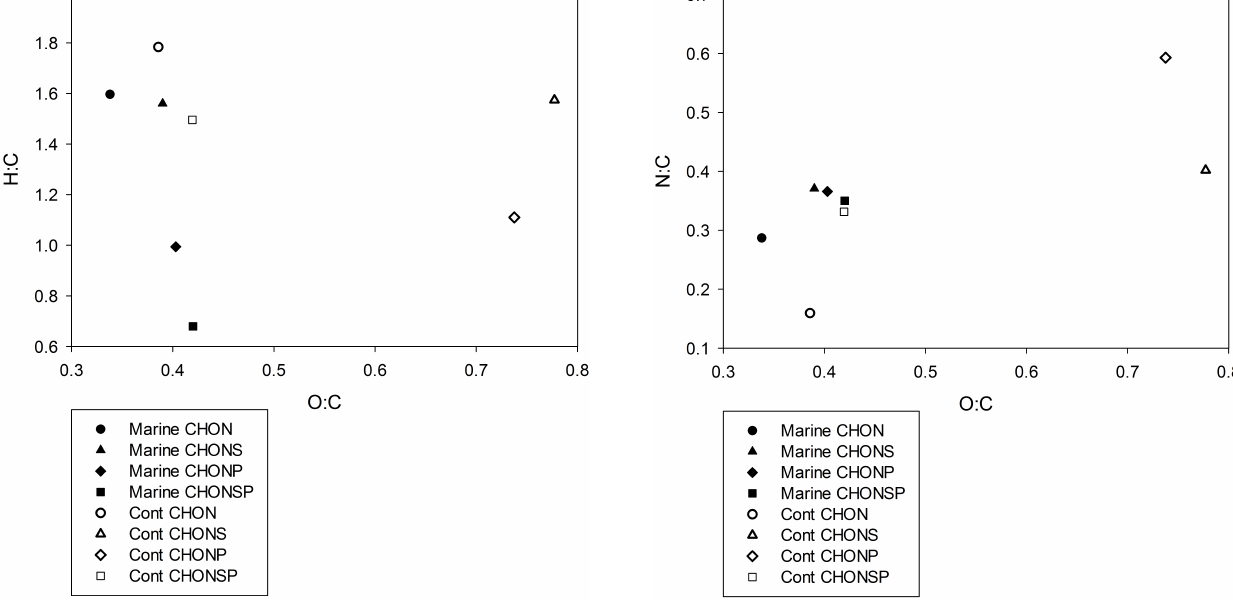
Fig. 4. N focused van Krevelen diagram of average elemental ratios of N containing compound classes in combined marine rainwater samples and previously published continental rainwater (Altieri et al.,